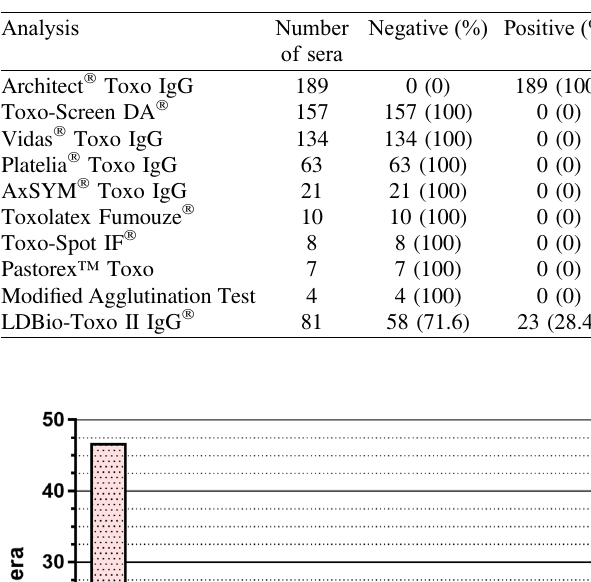
Table 2. Diagnostic tests performed.